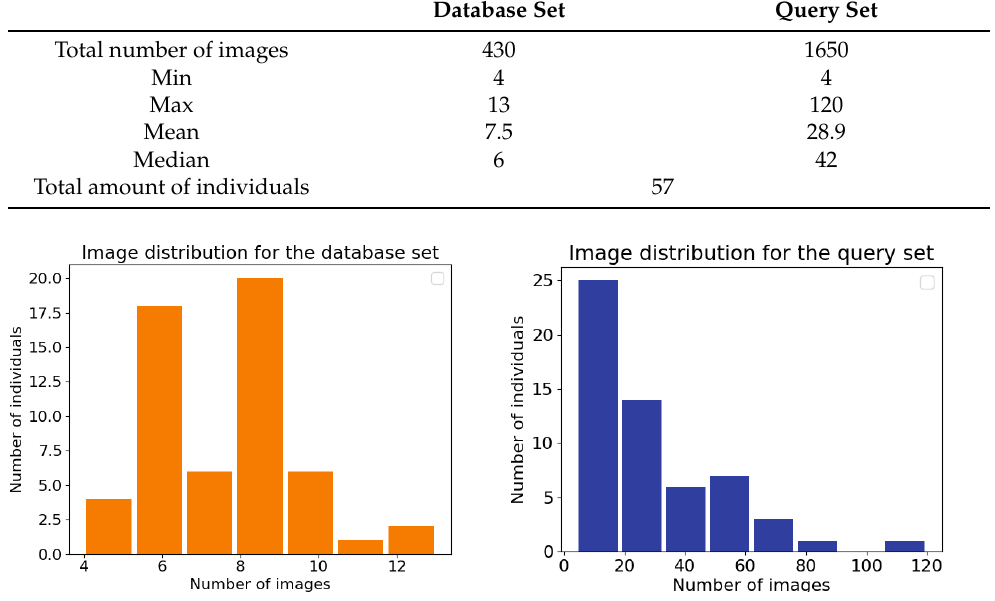
Figure 2. Image distributions for the database ( left ) and query sets ( right ). For example, in the query dataset ( right ), 25 individuals ( y -axis) had less than 20 images ( x